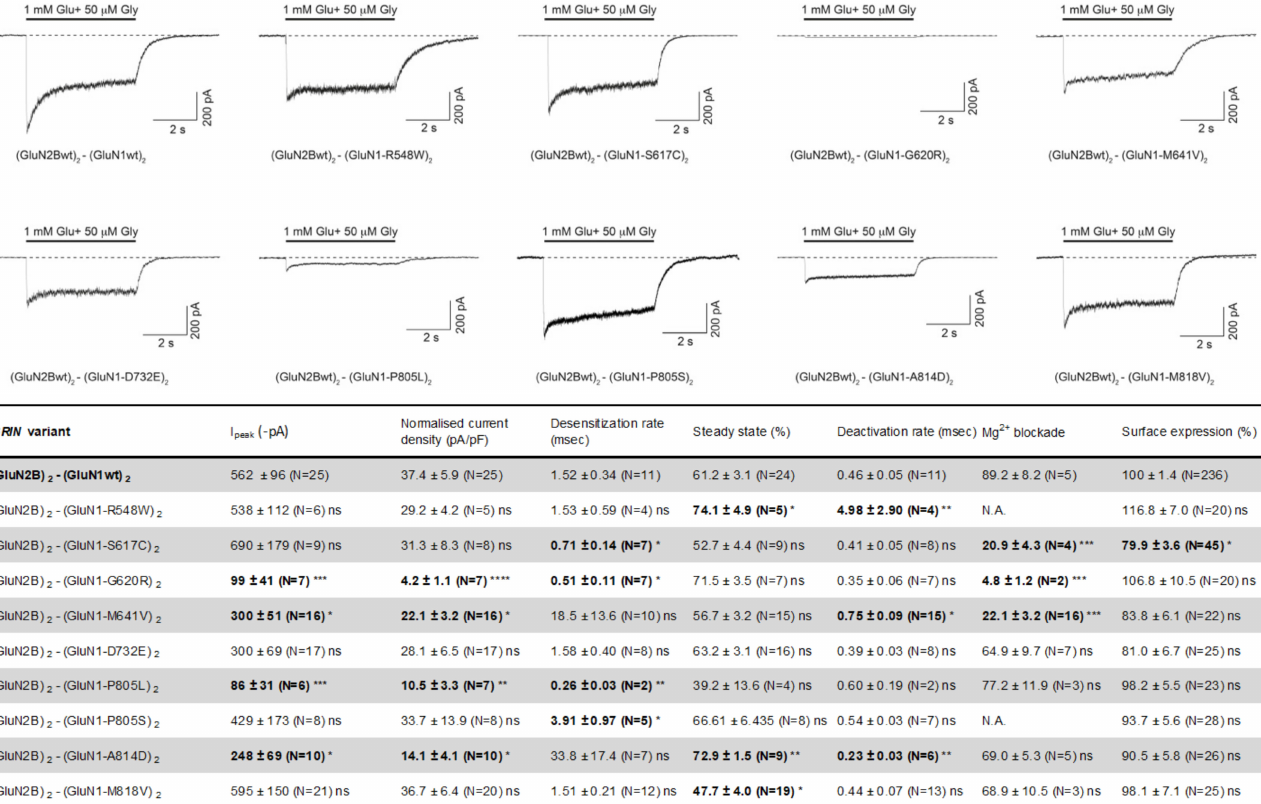
Figure 5. Electrophysiological characterisation of NMDAR-mediated currents in HEK-293T heterologously expressing disease-associated GRIN1 -DNVs. ( Top ) Representative electrophysiological traces of NMDAR-mediated currents in HEK- 293T cells transfected with biallelic GRIN1 -DNVs (or GRIN1-wt) and GRIN2B and co-activaded by simultaneous 5-sec (bar) application of 50 µ M glycine and 1 mM glutamate. ( Bottom ) Summary of functional annotations of GluN1-DNVs. Data representing mean ± SEM. ns non-significant statistical difference; * p < 0.05; ** p < 0.01; *** p < 0.001; **** p < 0.0001; NA, not assigned. Note: statistically significant differences in bold